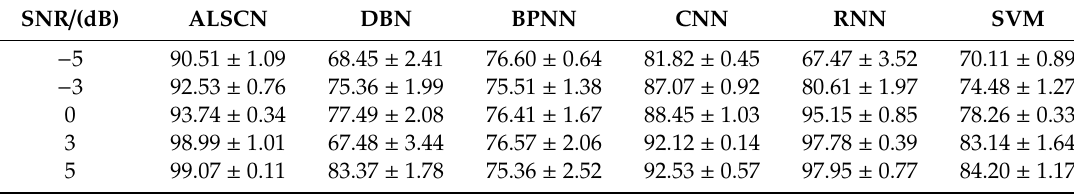
Table 7. The accuracy of different models with different SNR value on CWRU.